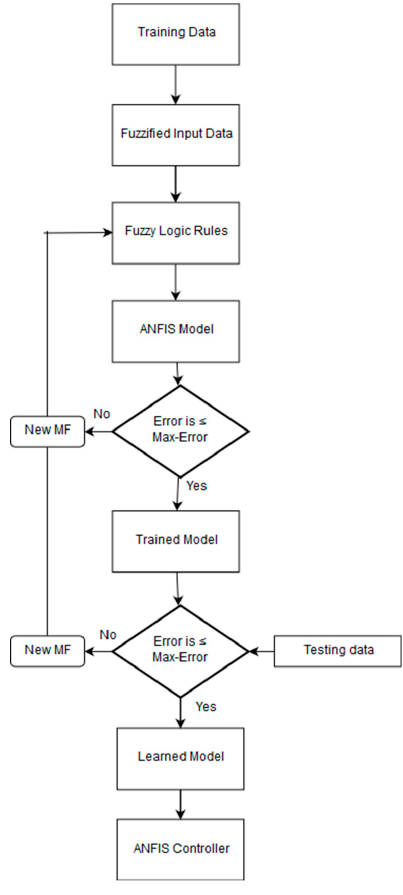
Figure 6. Training process.